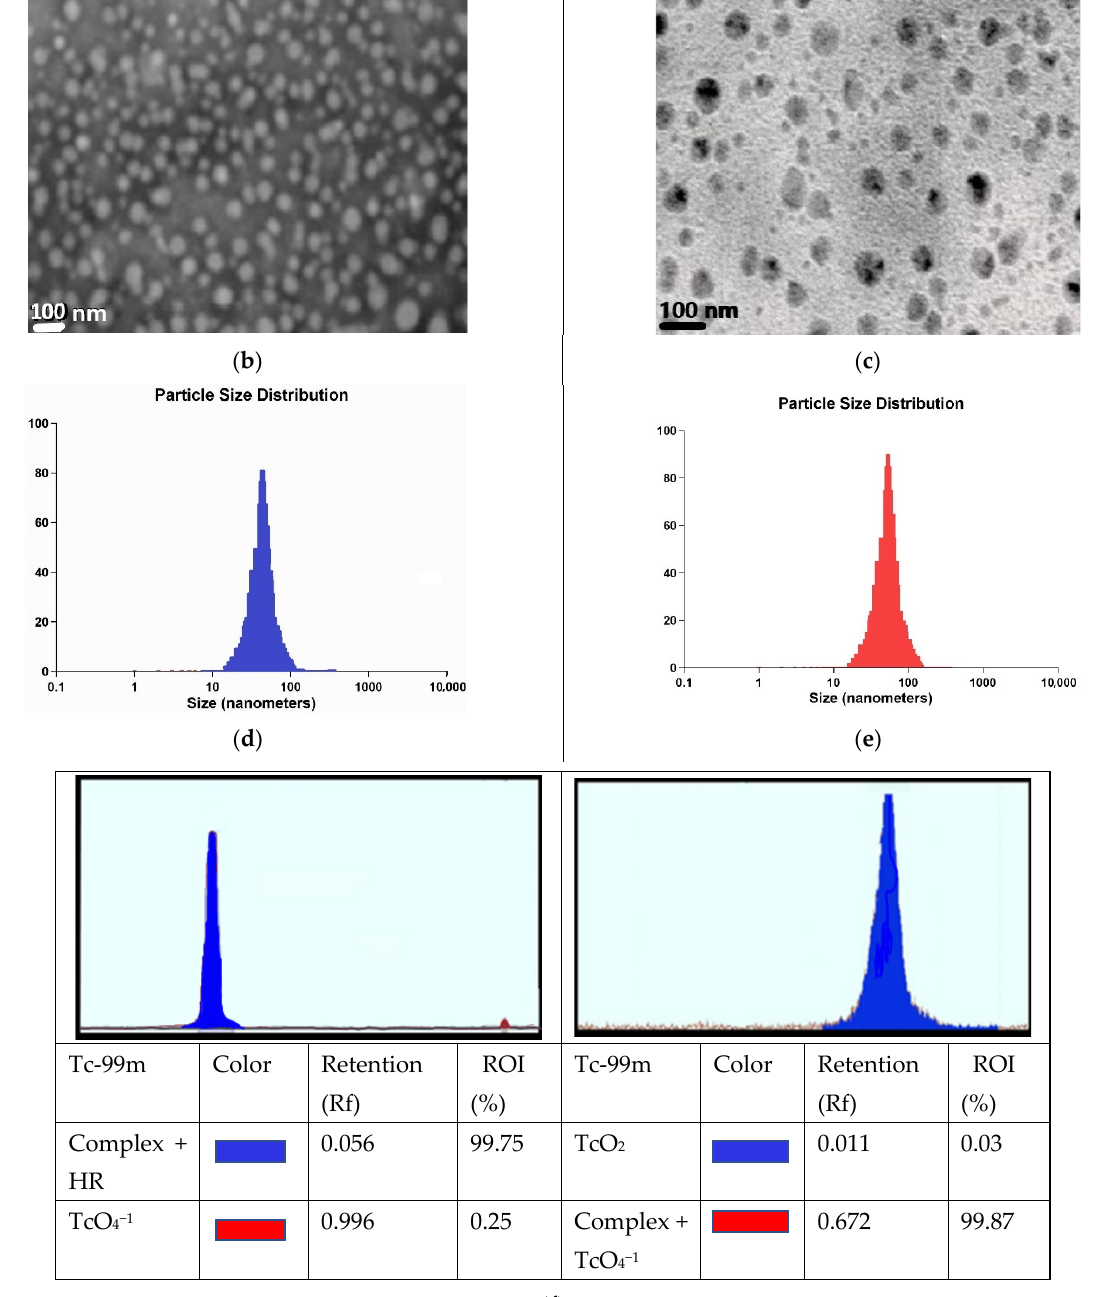
Figure 3. Uptake of FITC-GCPQ micelles ( a ) Live-cell confocal microscopy images of HepG2 cells treated with FITC-Q9P35GC, Q13P15GC, and Q20P15GC micelles. Red fluorescence from FITC GCPQ micelles, the blue flourescence is from nuclei staining, and the last column is the merge. The scale is 20 µm; Characterization of 99mTc Q9P35GC micelles. ( b ) Representative TEM image of Q9P35GC micelles with an average size of 60 ± 9.4 nm, n = 6; ( c ) Representative TEM image of 99mTc labelled Q9P35GC micelles with an average size of 65 ± 8.3 nm, n = 6; ( d , e ) Particle size distribution of Q9P35GC micelles and 99mTc Q9P35GC micelles as determined by DLS, respectively; ( f ) Chromatogram of radiochemical analysis showing labelling efficiency of 99m Tc Q9P35GC micelles using double-strip method. Strip one, ITLC-SG Chromatogram of 99m Tc Q9P35GC micelles and hydrocolloids at RF = 0 and Free TcO 4–1 at Rf = 1. Strip two, ITLC-SG Chromatogram of hydrocolloids at RF = 0 and Free TcO 4–1 and 99m Tc Q9P35GC micelles at Rf = 0.672.